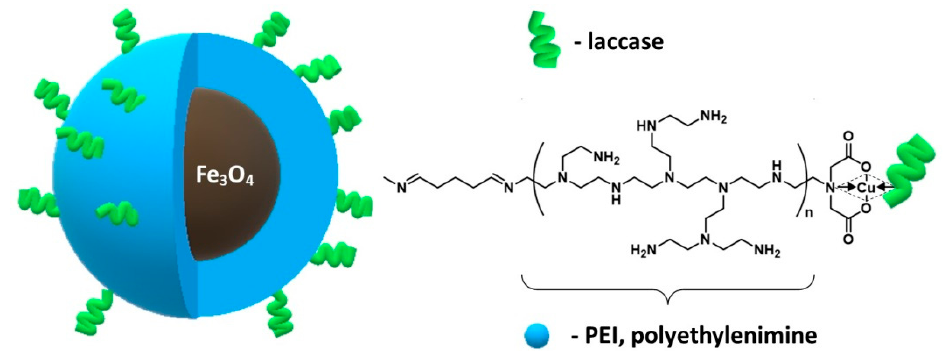
Figure 11. Scheme polyethylenimine-modified Fe 3 O 4 nanoparticles (Fe 3 O 4 –NH 2 –PEI NPs) structure with chelated Cu 2+ and immobilize laccase.